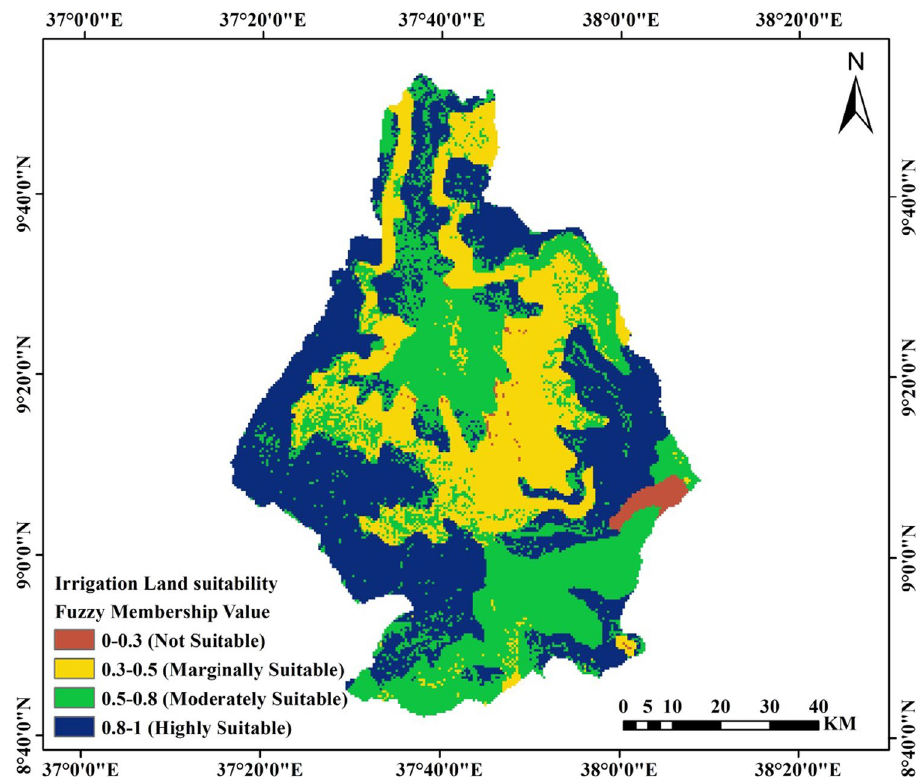
Fig. 13 Irrigation land suit- ability map along with the fuzzy membership values of Guder watershed,